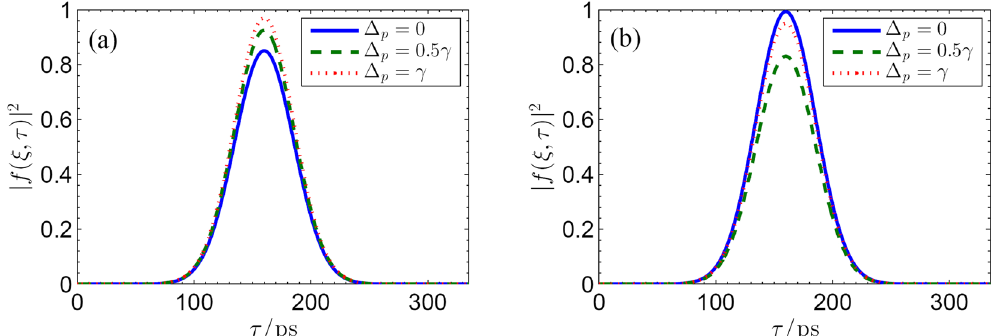
Figure 6. Snapshots of the temporal evolution of the infrared probe pulse at output terminal ( ξ ~ Δ z ) for 0 . The solid line, dashed line, and dotted line correspond to different cases, i.e., ( a ) Ω = 0 TH Δ = 0, 0.5 γ and γ , respectively. Other parameters are given as B = 3 T, γ p γ Ω = . 0 05